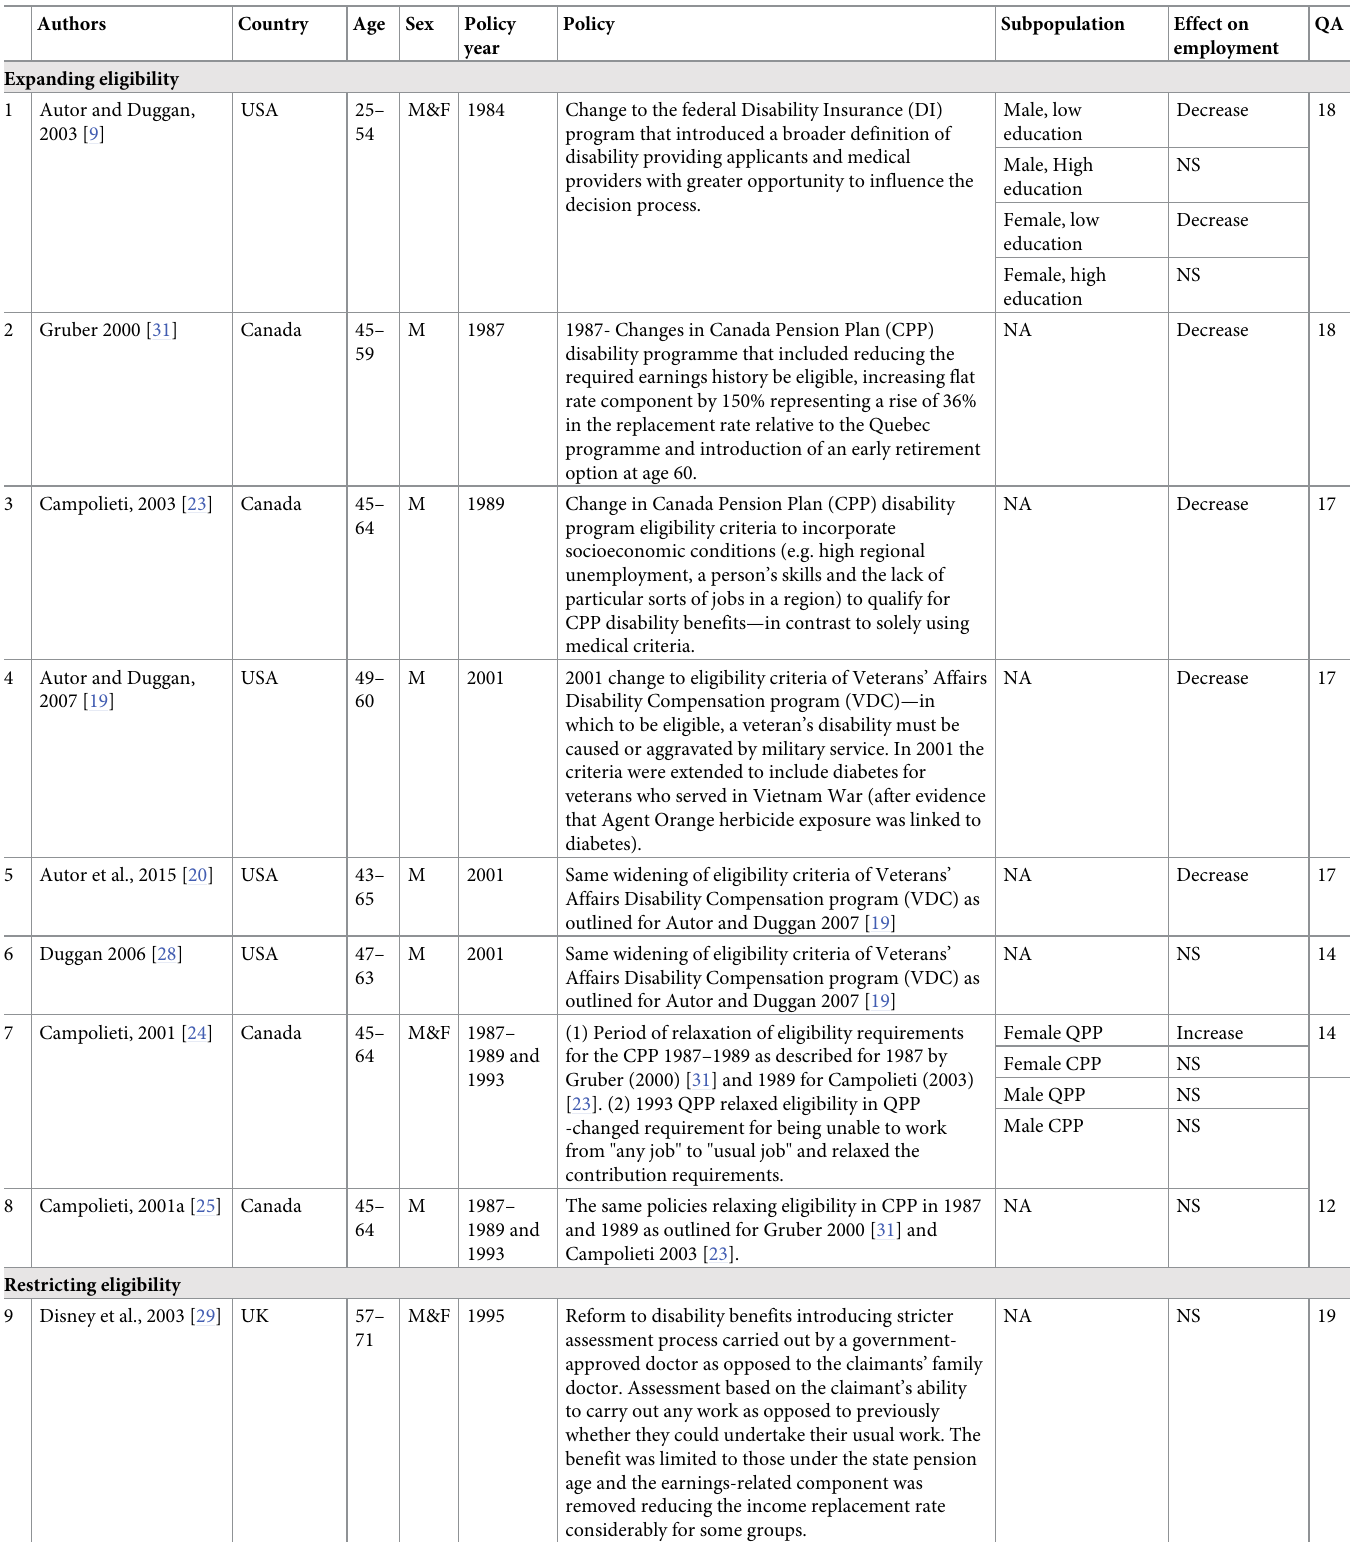
Table 2. Characteristics of included